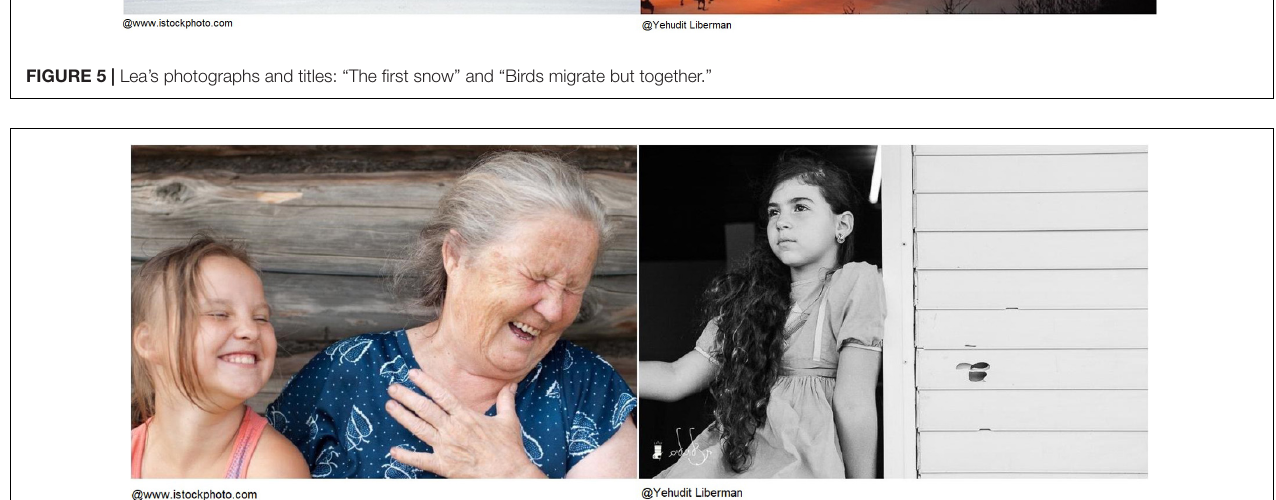
FIGURE 6 | Caterina’s chosen